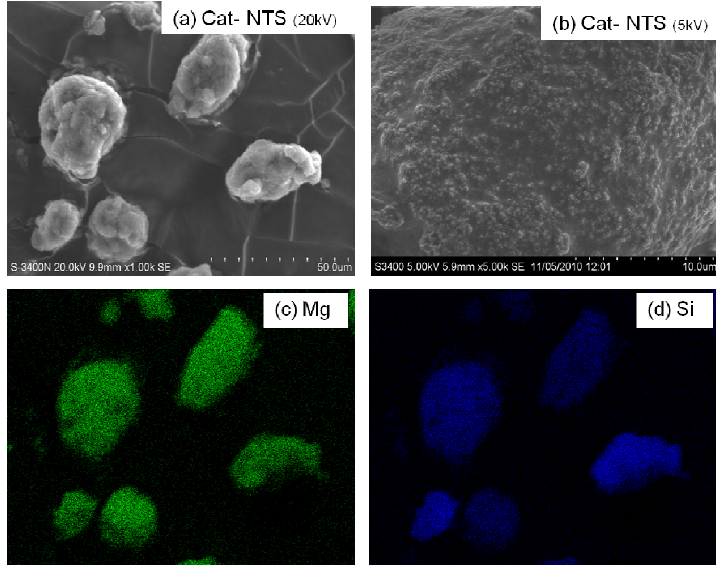
Figure 4. SEM micrograph and elemental distribution on Cat-NTS; (a) SEM image; (b) external surface; (c) Mg distribution; (d) Si distribution and (e) Ti